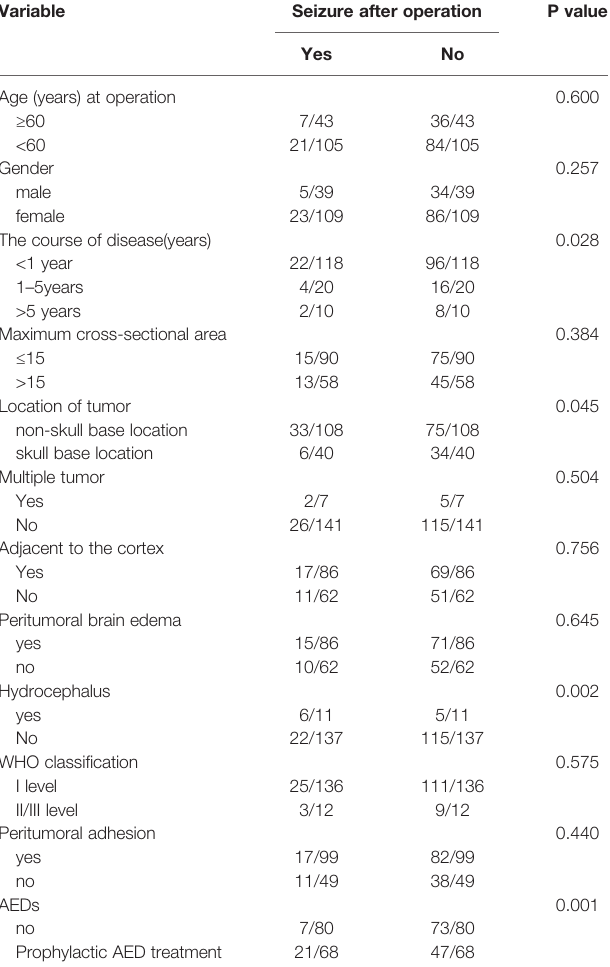
TABLE 3 | Baseline characteristics of participants excluding the patients with seizure attack before operation.